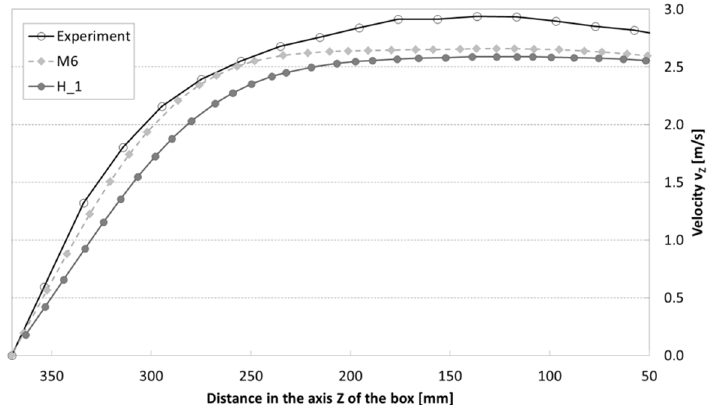
Figure 17. Comparison of the distribution of velocity components in the plenum box with side entry in the Z direction for Y = 0 mm for the experimental results, analysis without the air diffuser (M6),